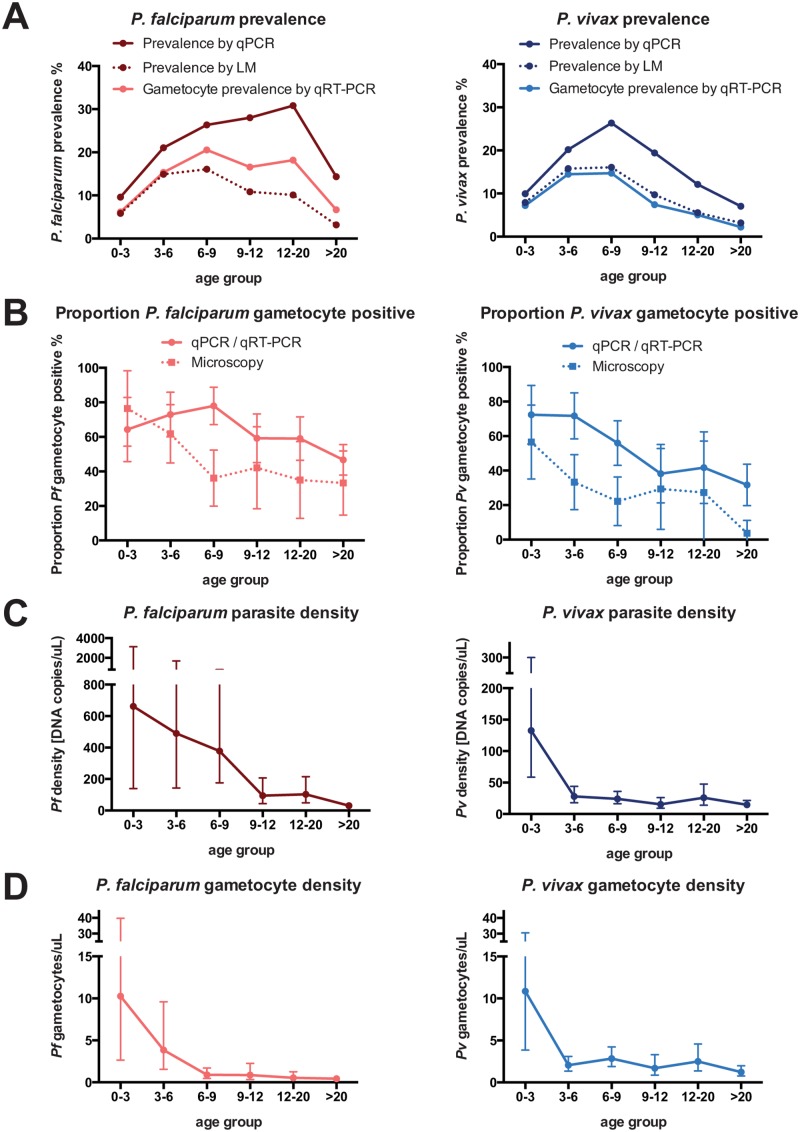
Age trends in P. falciparum and P. vivax blood-stage and gametocyte prevalence and density.Error bars represent CI95.